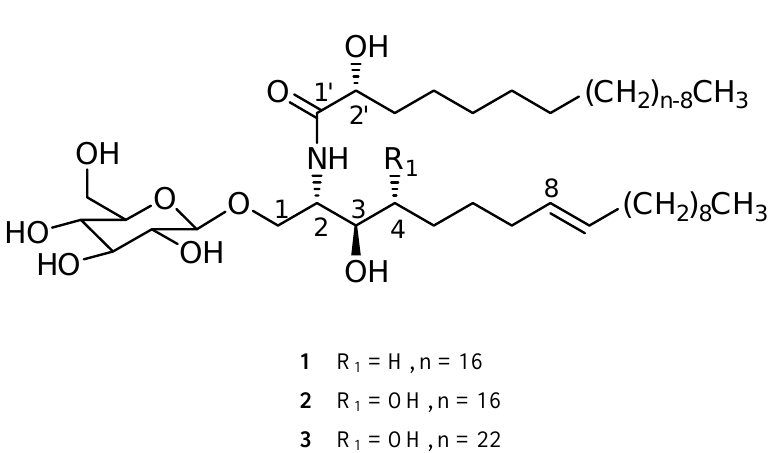
Figure 1. Structures of compounds 1 -